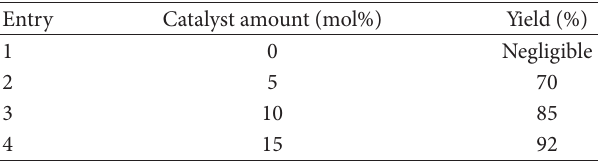
T 1: In�uence amount of aluminum nitrate on the yield of ethyl-6-methyl-4-phenyl-2-oxo-1,2,3,4-tetrahydropyrimidine-5- carboxylate in re�uxing ethanol a .